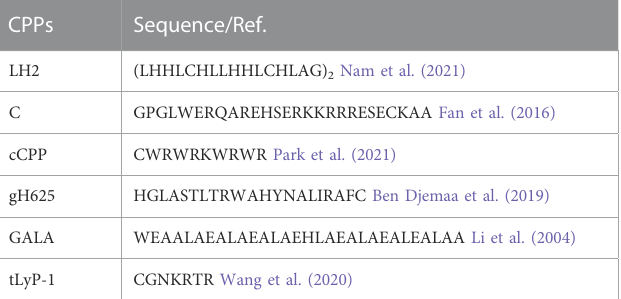
TABLE 2 Summary of the major cell penetrating peptides as anticancer drugs vectors for breast cancer therapy. CPPs